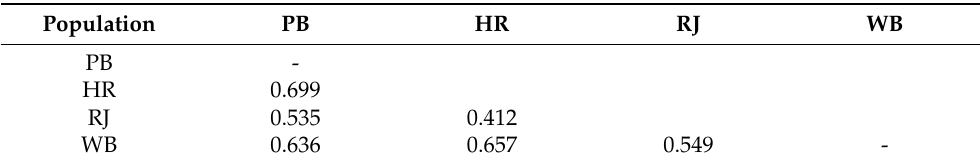
Table 8. Snn statistics of four different population of F. graminareum isolates of northern plains of India.